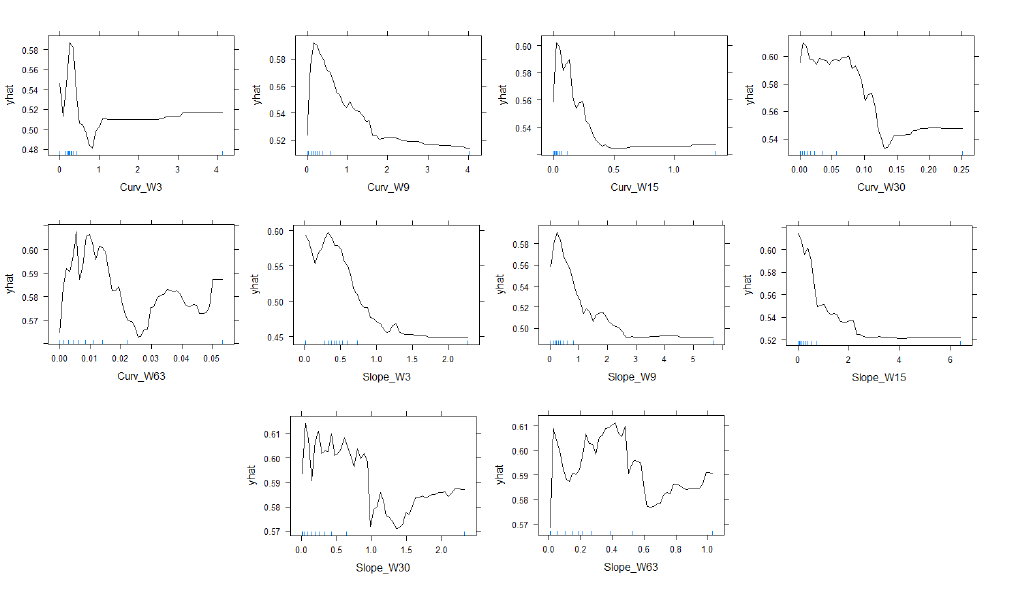
Figure 12. Partial dependence plots obtained for positive Curvature and Slope with NDVI for resampled rasters.